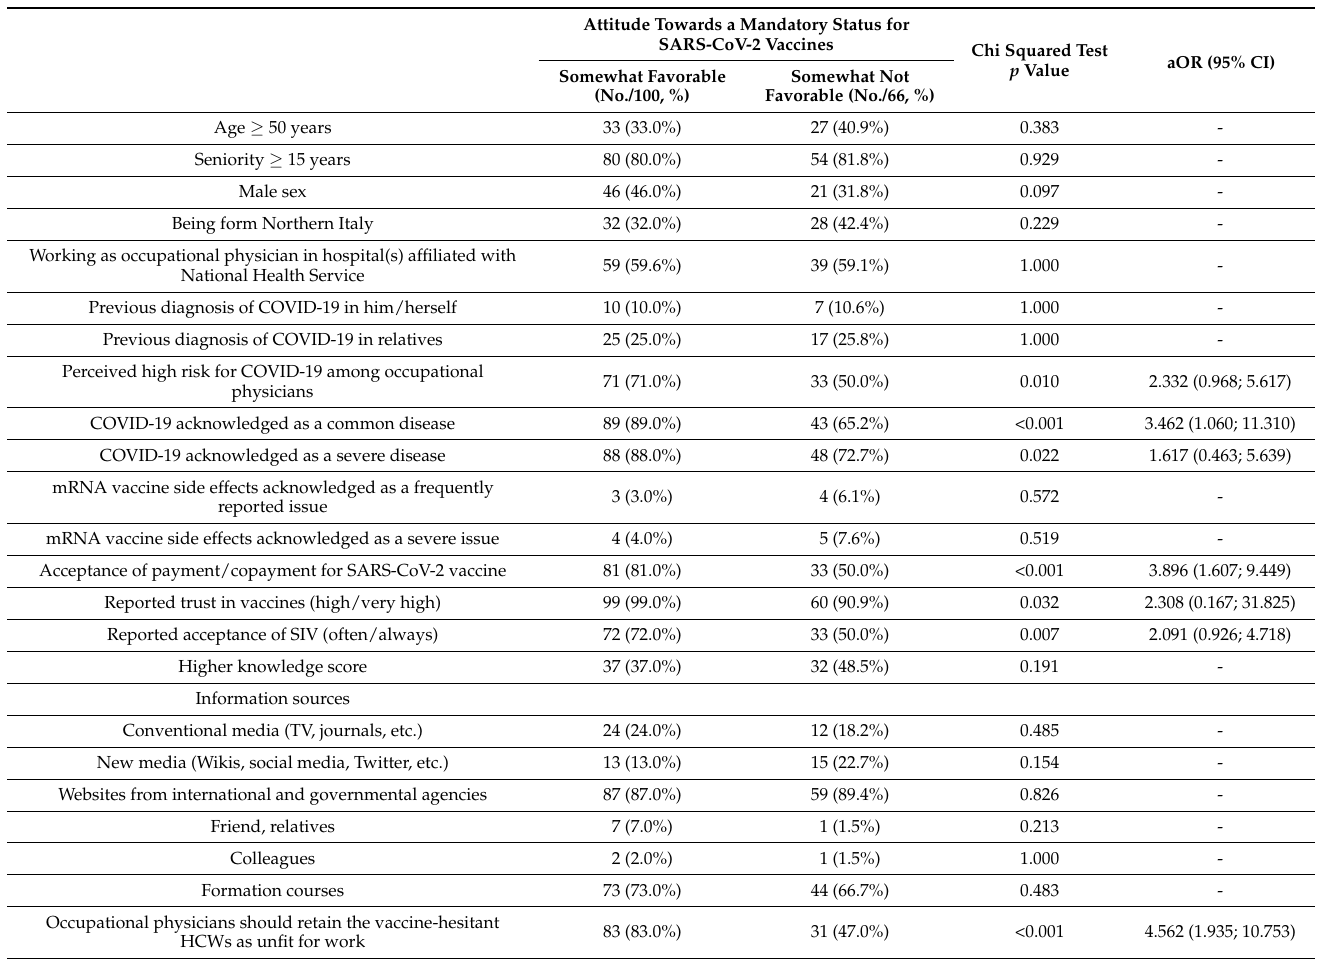
Table 5. Association of individual characteristics with attitudes towards a mandatory status for SARS-CoV-2 vaccine in 166 Italian occupational physicians (January 2021). Adjusted odds ratios (aOR) were calculated with their respective 95% CI by means of a binary regression analysis model, including all factors that, in univariate analysis, were associated with a favorable attitude towards a mandatory status for SARS-CoV-2 vaccine with p <